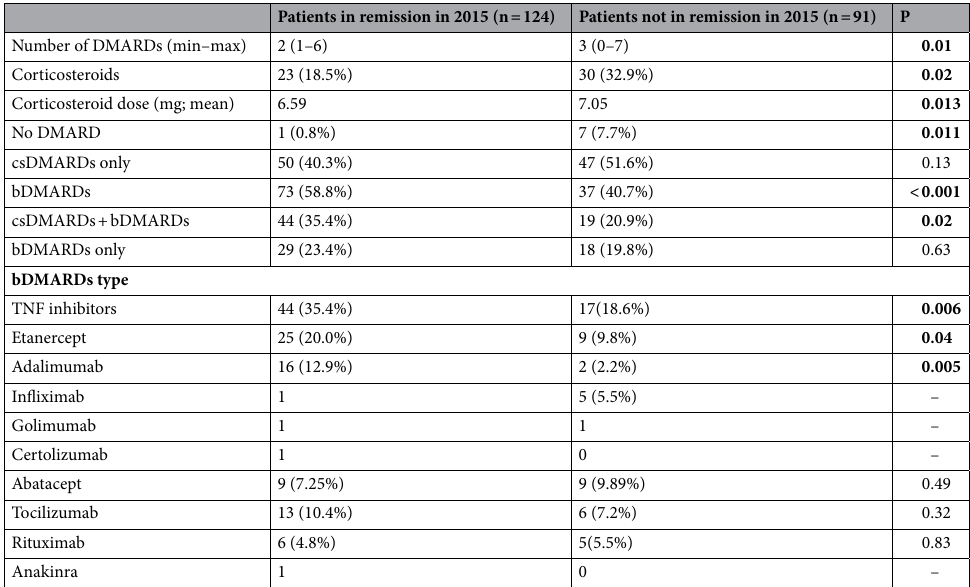
Table 3. Comparison of treatment use in 2015 between patients in remission and those not in remission (n = 215). Significant values are in bold.